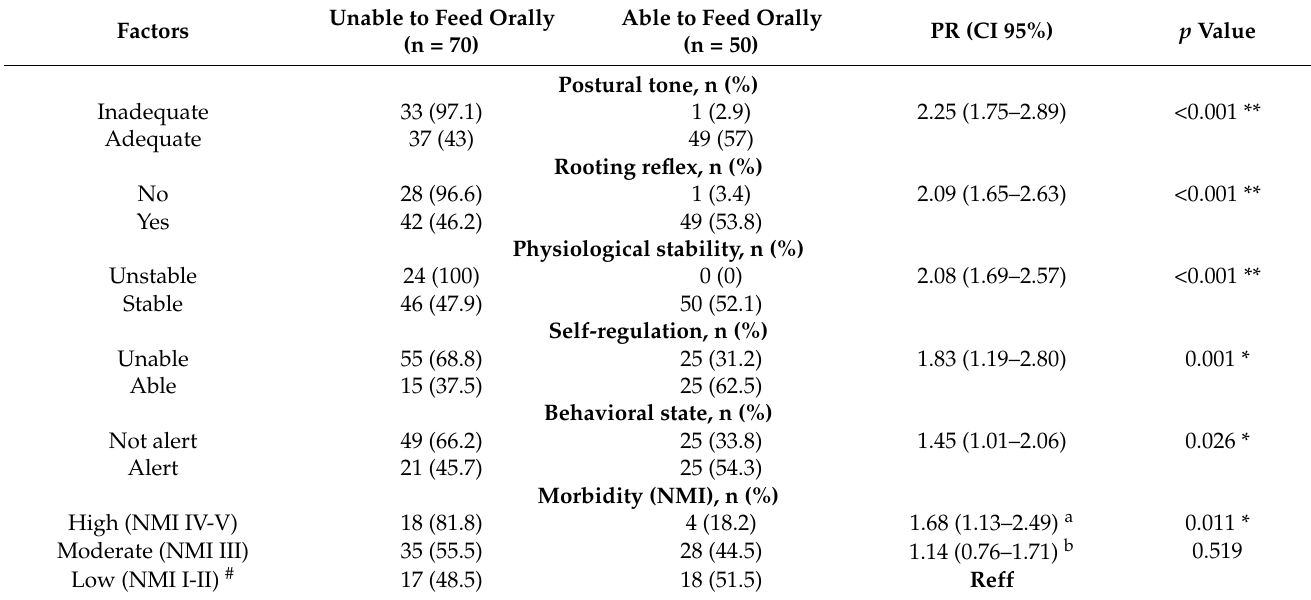
Table 2. Bivariate analysis on factors affecting oral feeding ability.